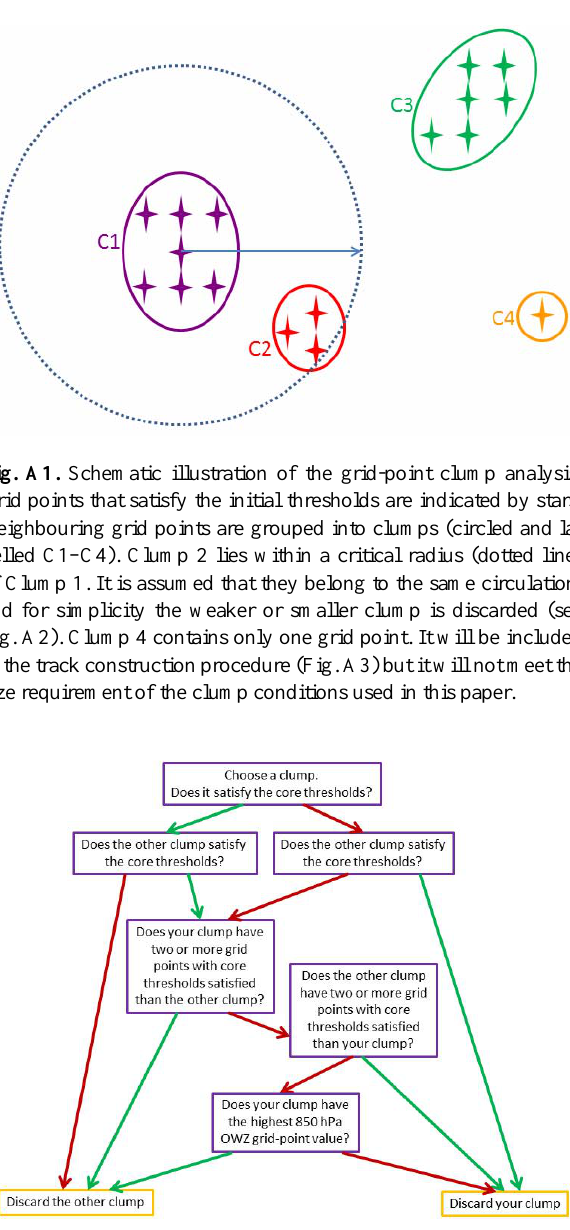
Fig. A2. Flow chart describing the decision making pathway for choosing which of two nearby grid point clumps is to be retained and which is to be discarded. Green arrows represent a yes response to the questions posed and red arrows represent a no response.